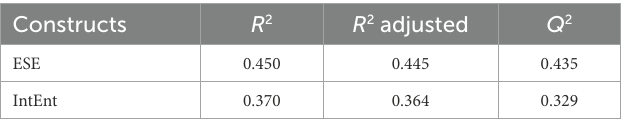
TABLE 4 R 2 and Q 2 . Constructs